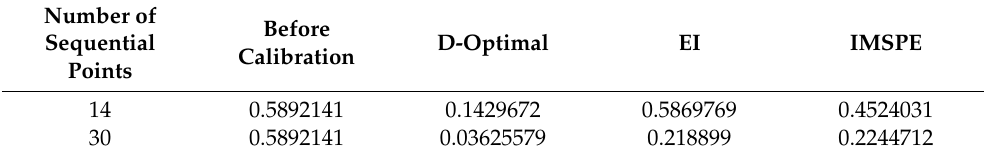
Table 1. The results about MSPE l